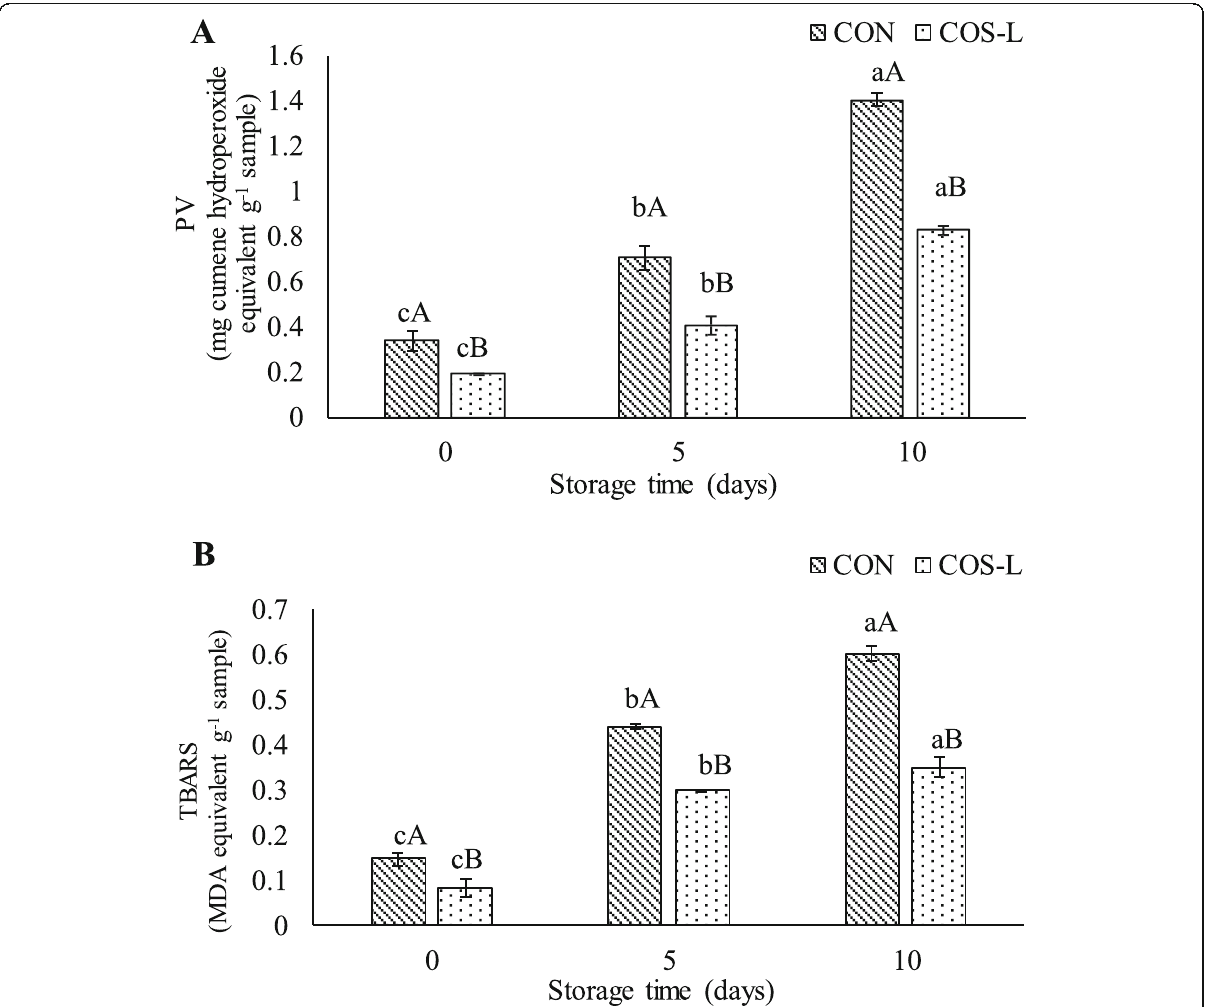
Fig. 3 Peroxide value (PV) ( a ) and thiobarbituric acid reactive substances (TBARS) ( b ) of sardine surimi gels without and with 1% COS-L from squid pen during refrigerated storage at 4 °C for 10 days. CON: gel without addition of COS-L; COS-L: gel added with 1% COS-L. Bars represent the standard deviation ( n = 3). Different lowercase letters on the bars within the same sample indicate significant differences ( p < 0.05). Different uppercase letters on the bars within the same storage time indicate significant differences ( p <